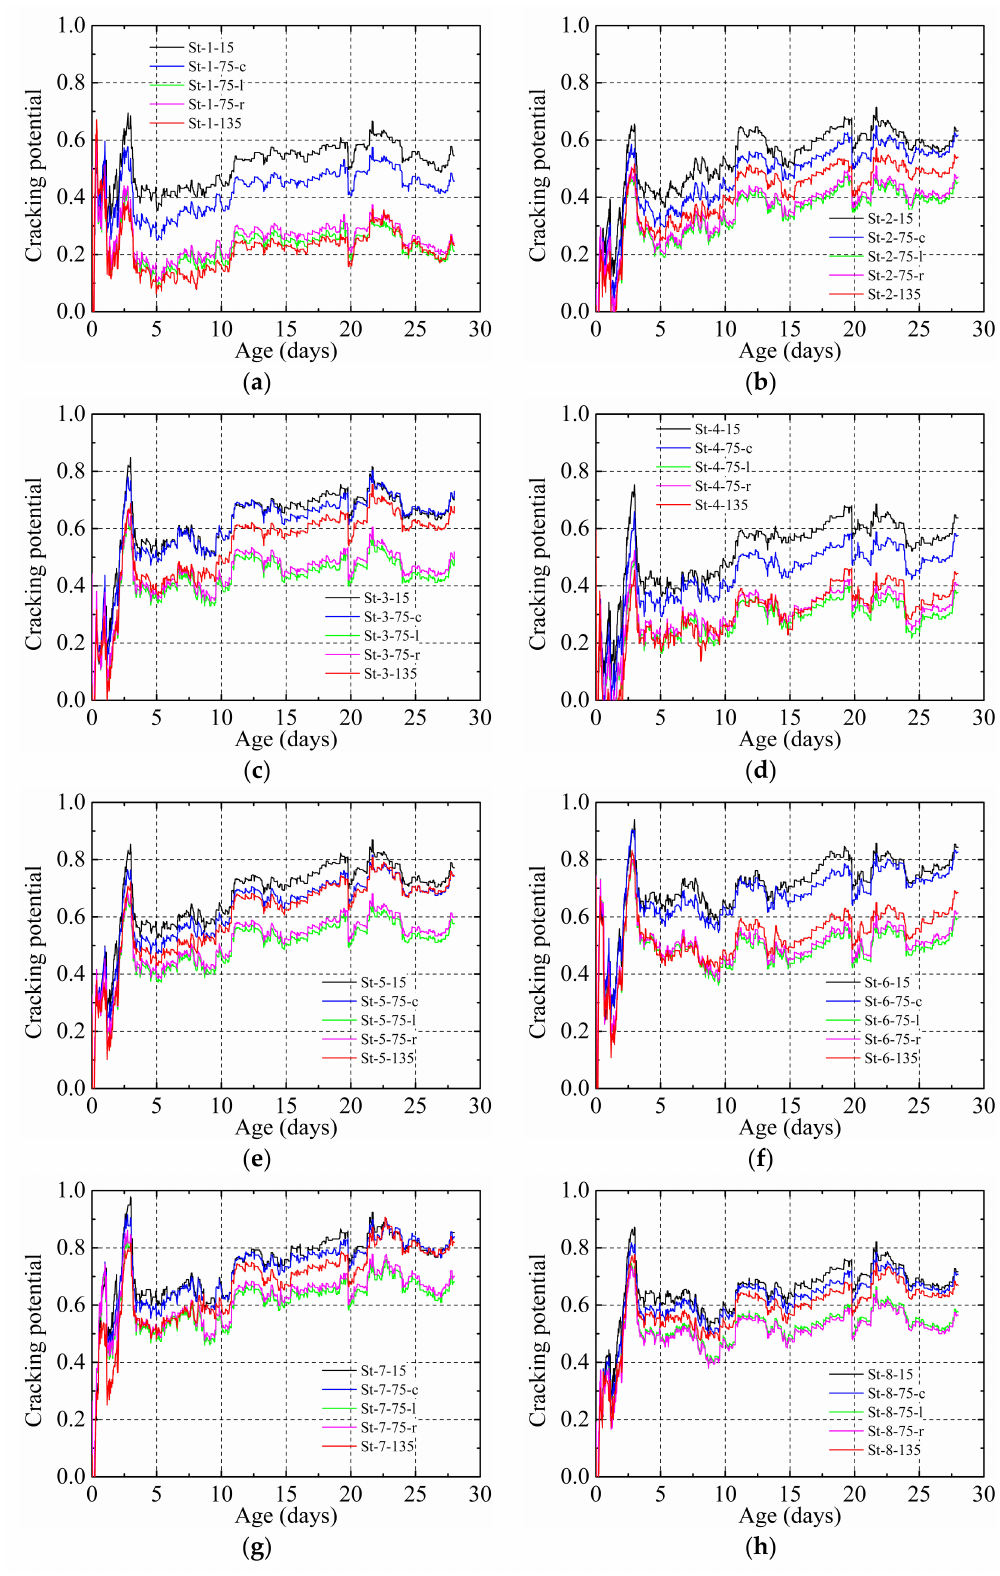
Figure 16. Cracking potential of the HPC restrained by steel plate and stud: ( a ) St-1, ( b ) St-2, ( c ) St-3, ( d ) St-4, ( e ) St-5, ( f ) St-6, ( g ) St-7, and ( h )